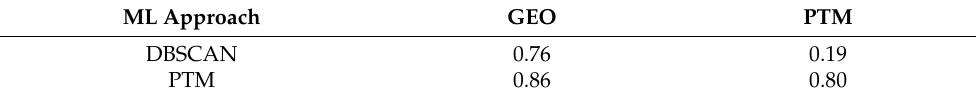
Table 3. Average accuracy of DBSCAN and LOF for the datasets GEO and